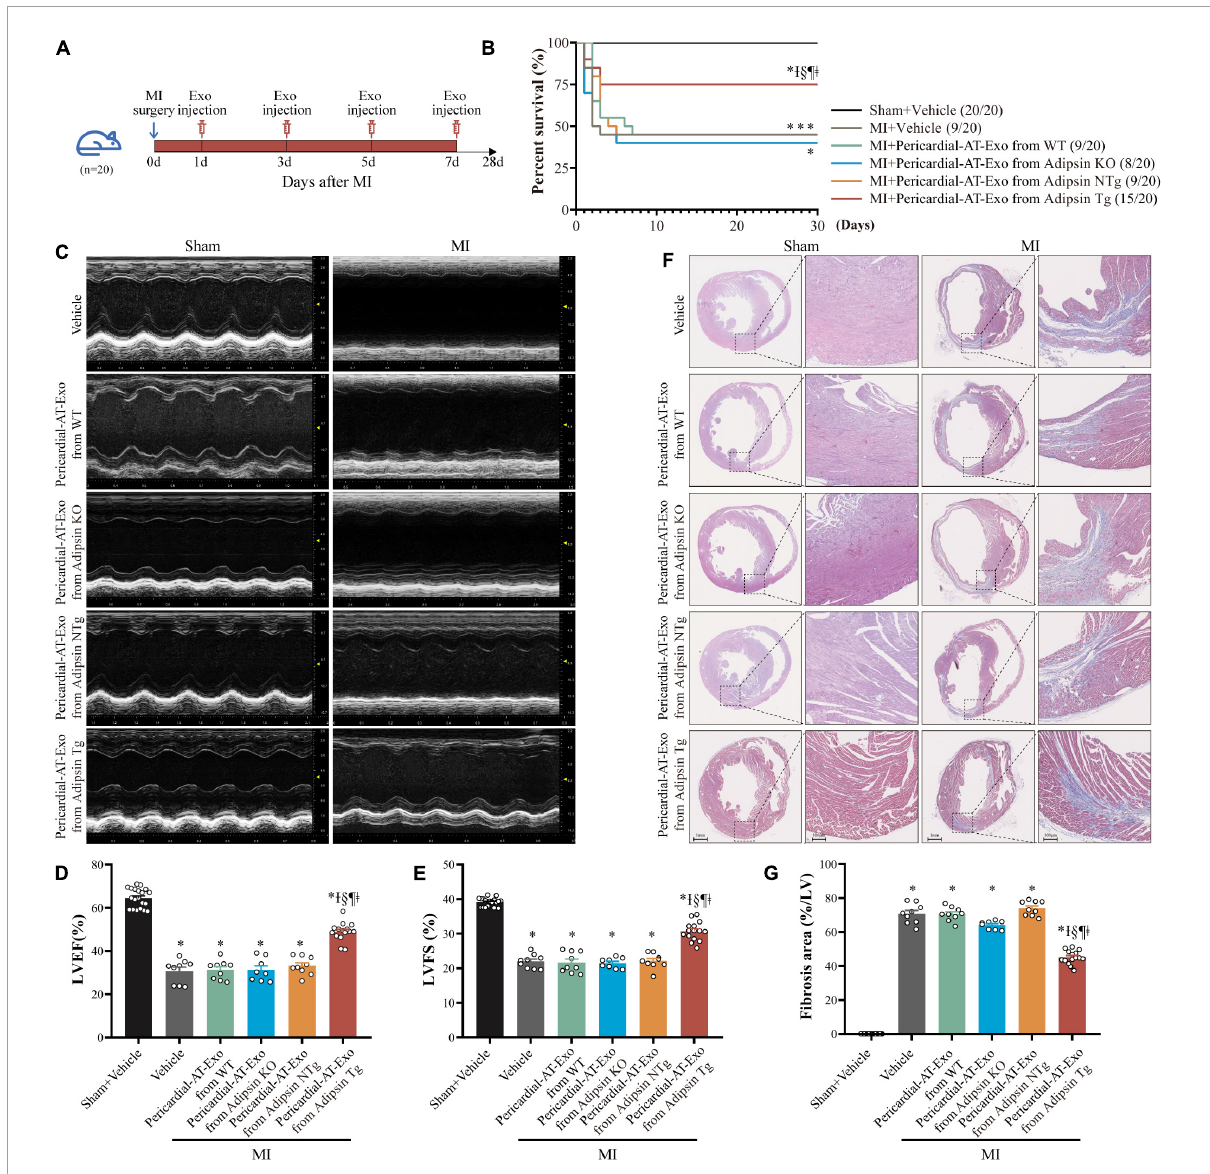
FIGURE3 Pericardial-AT Exo of Adipsin overexpression mice alleviate MI-induced cardiac injury. (A) Schematic illustration of experimental procedure. MI mice were injected exosomes isolated from pericardial adipose tissue of donor mice (WT, Adipsin-KO, Adipsin-NTg, and Adipsin-Tg) on the first, third, fifth and seventh day via tail veins after MI surgery. Echocardiography and hearts collection were done 28 days after MI surgery. (B) Survival curves. Each group n = 20. * p < 0.05 vs. Sham + Vehicle group, I p < 0.05 vs. MI + Vehicle group, § p < 0.05 vs. MI + Pericardial-AT-Exosomes from WT mice group, ¶ p < 0.05 vs. MI + Pericardial-AT Exosomes from Adipsin-KO mice group, ‡ p < 0.05 vs. MI + Pericardial-AT Exosomes from Adipsin-NTg mice group. (C) Representative echocardiographic images 28 days after MI surgery. (D,E) Left ventricular ejection fraction (LVEF) and fractional shortening (LVFS) of each group ( n = 8–20). * p < 0.05 vs. Sham + Vehicle group, I p < 0.05 vs. MI + Vehicle group, § p < 0.05 vs. MI + Pericardial-AT-Exosomes from WT group, ¶ p < 0.05 vs. MI + Pericardial-AT Exosomes from Adipsin-KO group, ‡ p < 0.05 vs. MI + Pericardial-AT Exosomes from Adipsin-NTg group. (F,G) Representative images of Masson’s trichrome staining (transverse) and quantification of fibrotic area ( n = 8–20). * p < 0.05 vs. Sham + Vehicle group, I p < 0.05 vs. MI + Vehicle group, § p < 0.05 vs. MI + Pericardial-AT-Exosomes from WT group, ¶ p < 0.05 vs. MI + Pericardial-AT Exosomes from Adipsin-KO group, ‡ p < 0.05 vs. MI + Pericardial-AT Exosomes from Adipsin-NTg group. Survival curves were analyzed using Gehan–Breslow–Wilcoxon test. Mean ± SEM, Data for (D,E,G) and one-way ANOVA was used for statistical